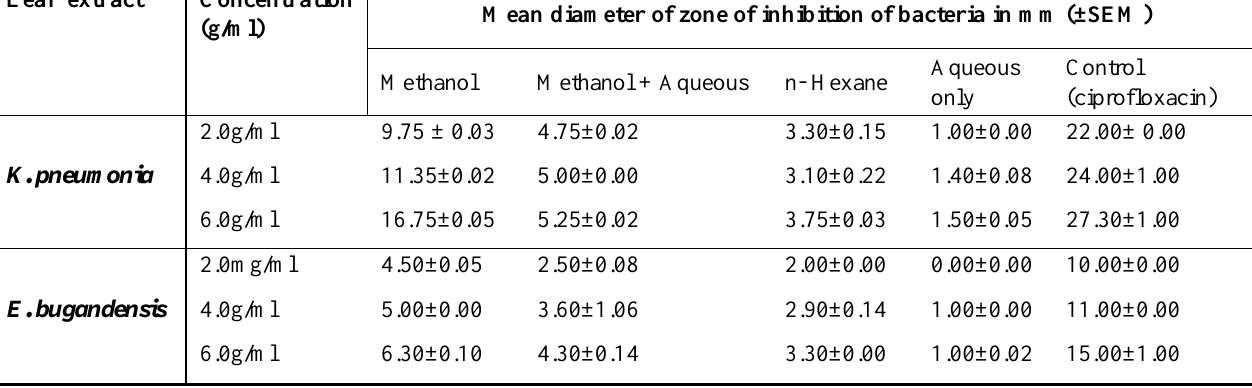
Table 1 : Antibacterial activities of bitter leaf extract on K. pneumonia and E. bugandensis (AdM2). Leaf extract